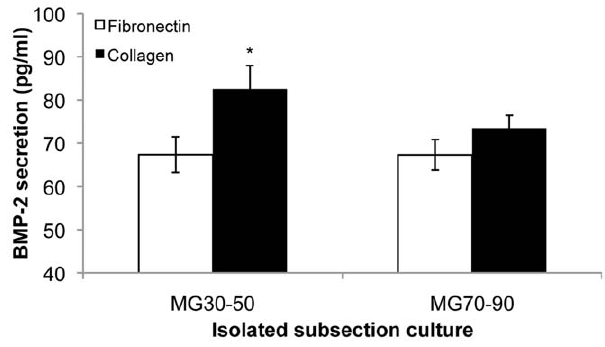
Figure 9. Assessing BMP-2 secretion. BMP-2 expression was assessed from individual cultures of MG subsections secreted in the media, which was expressed at a higher level on MG30–50 collagen substrates. * statistical difference (p , 0.05) compared to 40 kPa fibronectin condition.